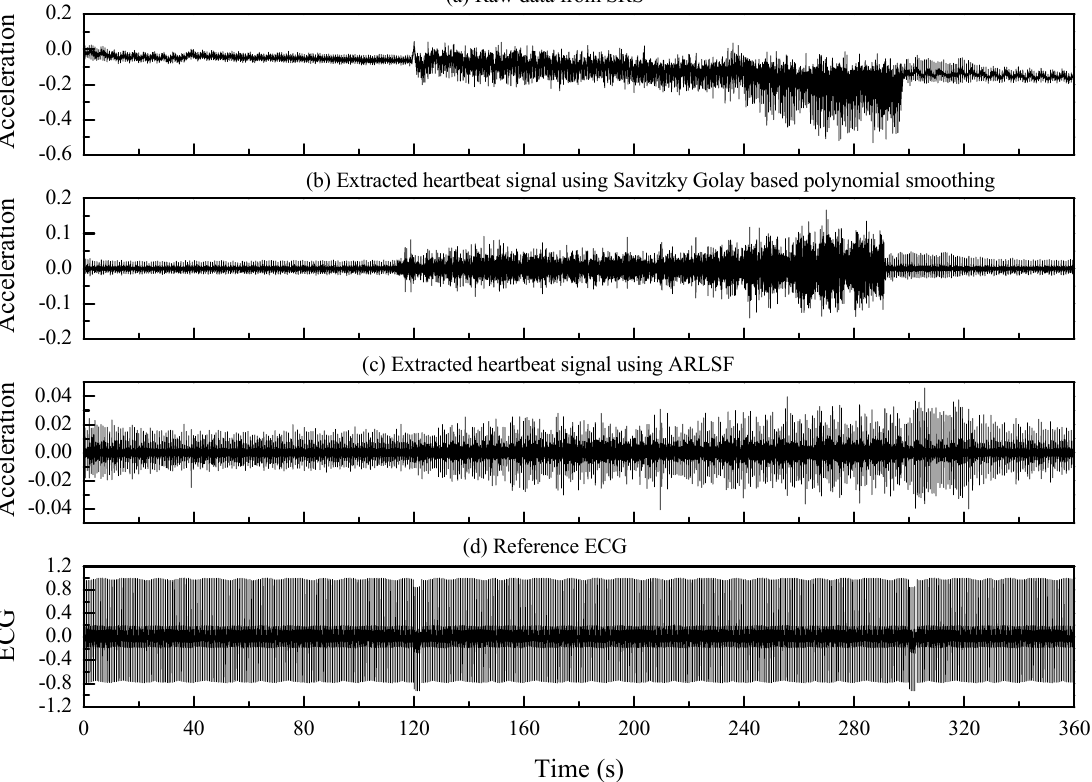
Figure 9. ( a ) Raw data from SRS. ( b ) Extracted heartbeat signal using Savitzky Golay filter. ( c ) Extracted heartbeat signal using ARLSF. ( d ) The reference ECG lead I signal. (The units of acceleration and ECG are g and mV, respectively.) Sensors 2020 , 20 , x